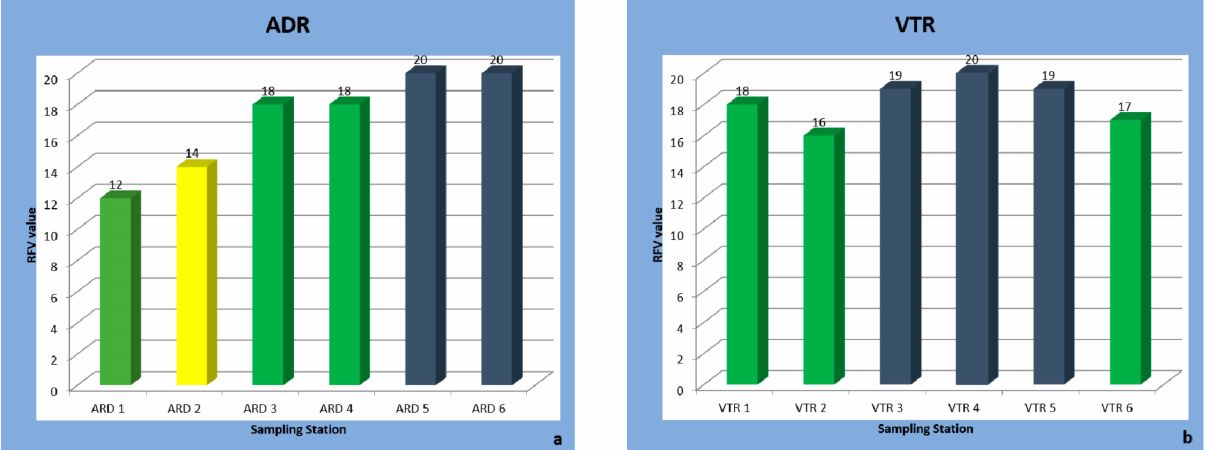
Figure 5. The riparian forest evaluation (RFV) protocol values for the ( a ) ADR and ( b ) the VTR sampling stations. The blue column indicates that the stations is in very good condition, the green in good condition, the yellow in moderate condition and the orange in poor